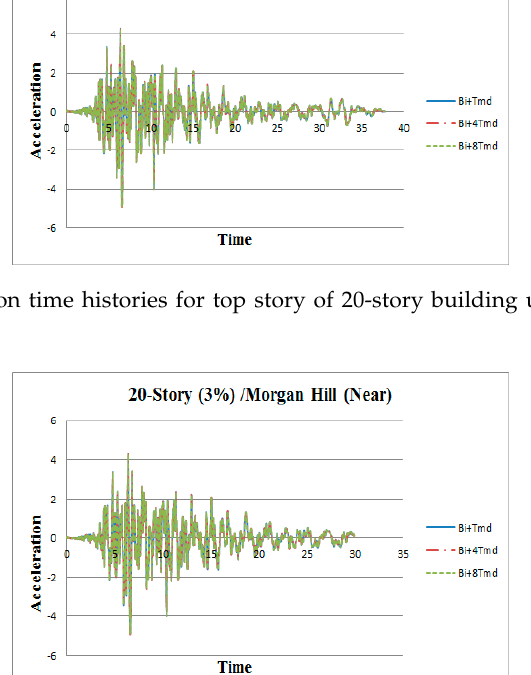
Figure A12. Acceleration time histories for top story of 20-story building under the Morgan Hill (near-fault) earthquake.